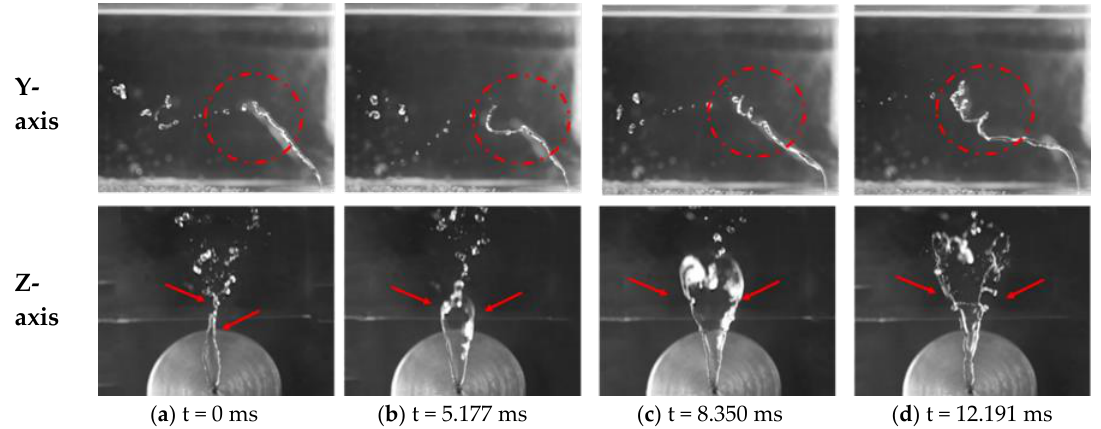
Figure 6. Arcade breakup mechanism for We g = 2.90 We j = 245.76 d j = 1 mm. Figure 5. Bump breakup mechanism for We g = 1.43 We j = 162.11 d j = 1 mm.